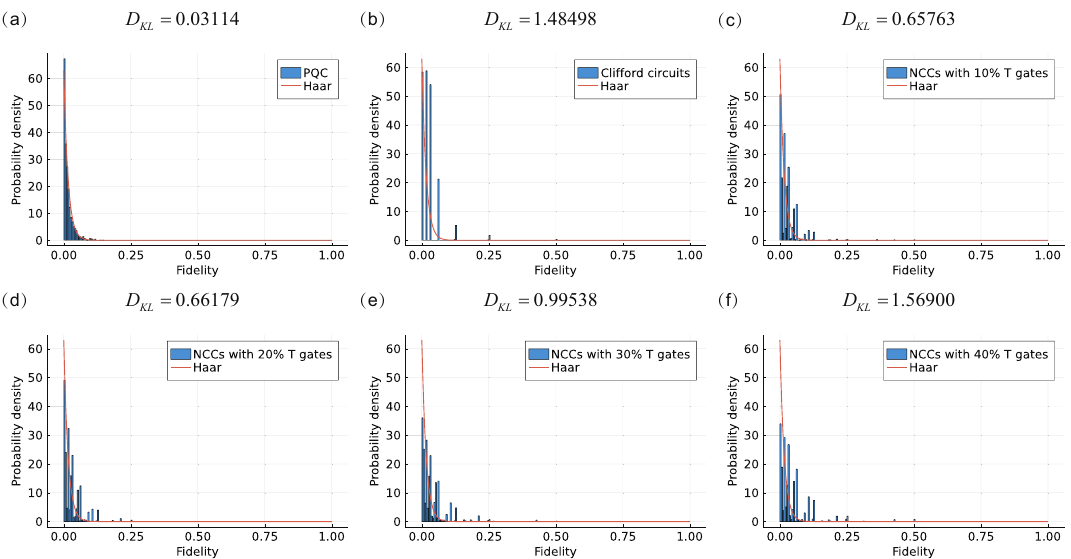
Figure 3. Histograms of estimated fidelities normalized to a discrete probability density function. NCC and PQC diagrams are shown in Figure 2a,b, respectively, and we set the probability of T gate appearing from 0 (CC) to 40% with step 10%. For NCC (PQC), 2000 sample pairs of gate sequences (circuit parameter vectors) were uniformly generated, corresponding to 4000 states in Hilbert space using Yao in Julia. Histograms of estimated fidelities normalized to a discrete probability density function are shown with the computed KL divergence above the